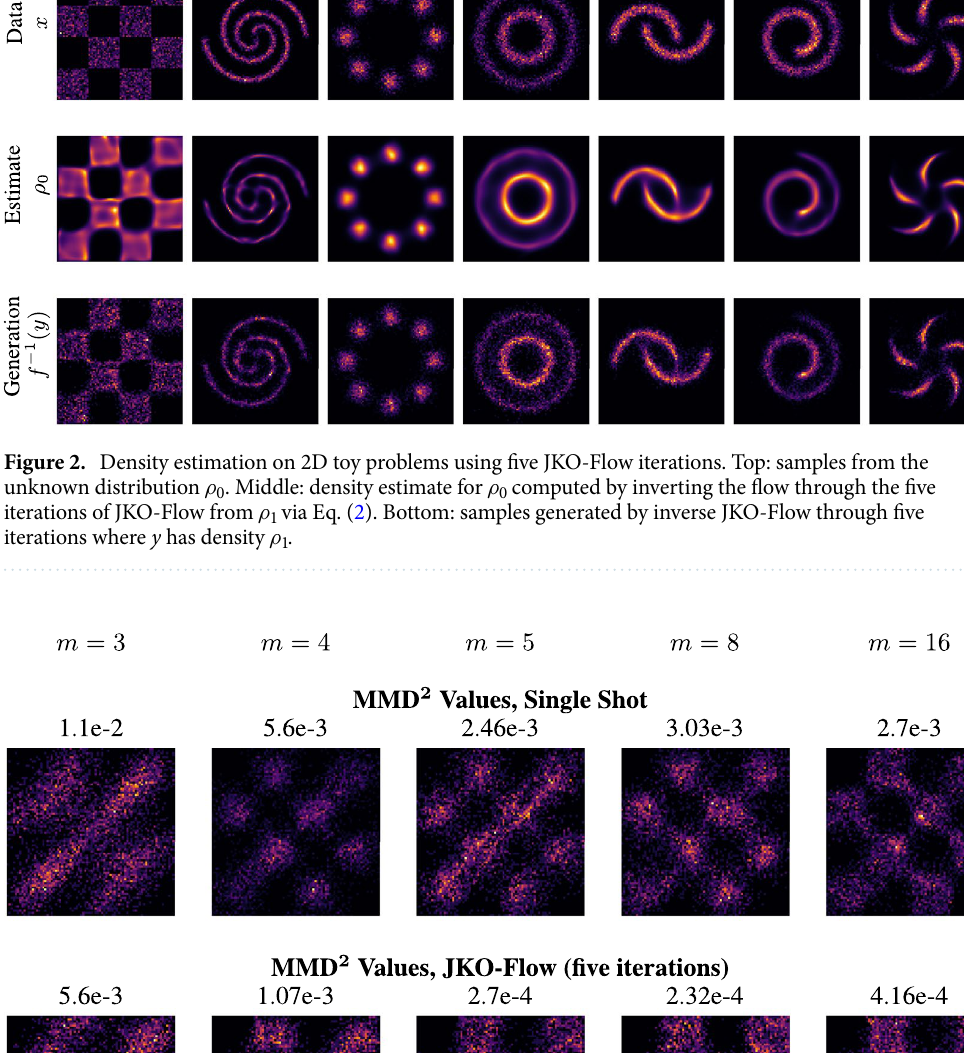
Figure 3. Checkerboard dataset: generated samples of